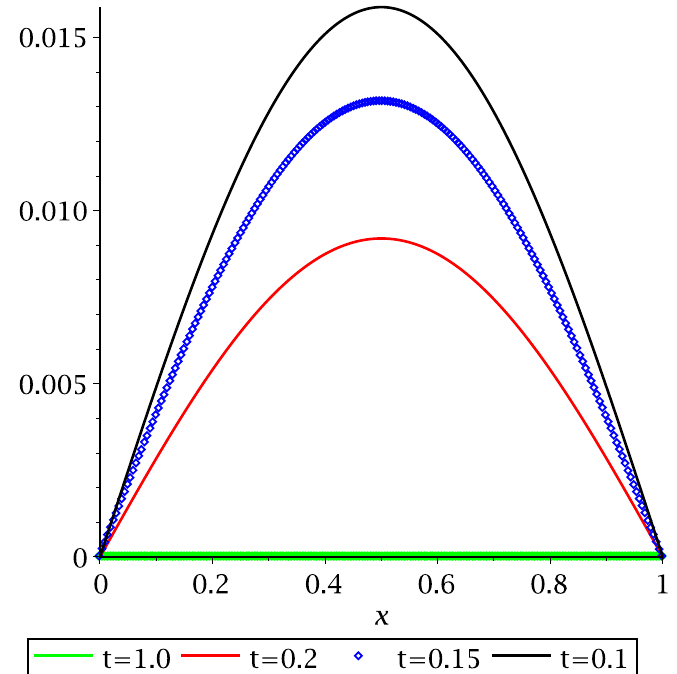
Figure 1. The state of system (15) for z ( x ,0 ) = sin ( π x ) , t = 0.1, t = 0.15, t = 0.2, and t = 1.0, illustrating the fact that (15) is strongly stable on Ω =] 0,1 [